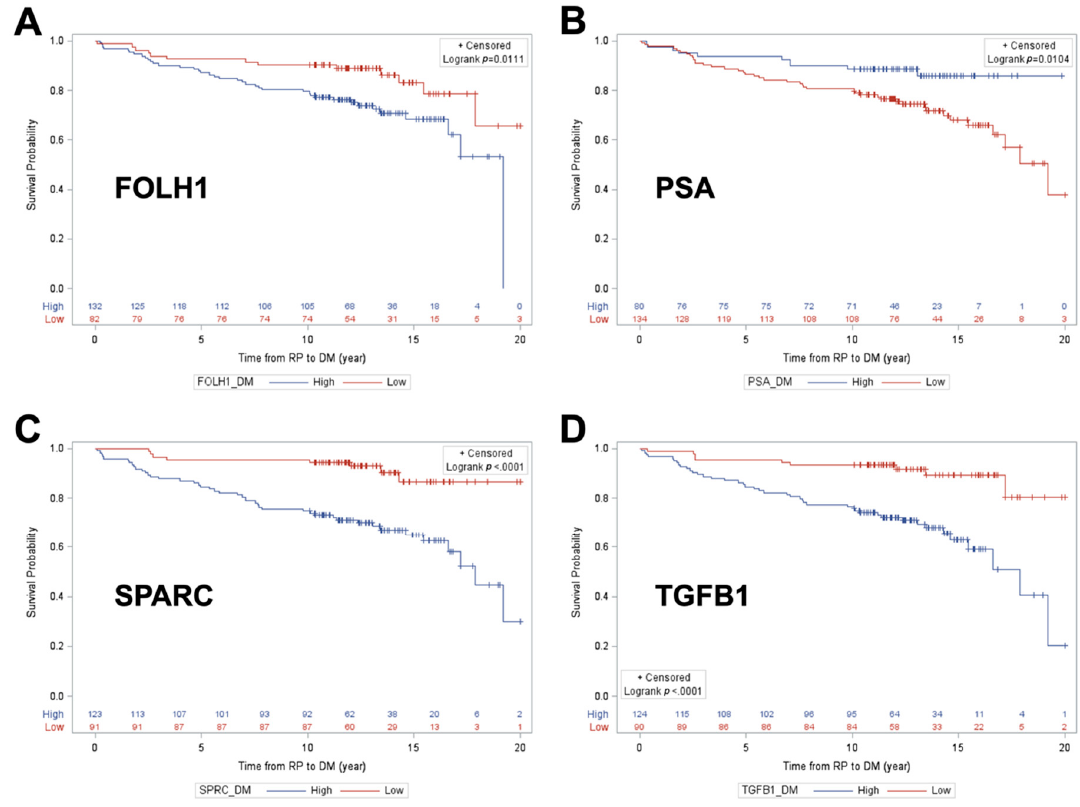
Figure 2. Kaplan–Meier DM-free survival curves across high versus low groups for FOLH1 ( A ), PSA ( B ), SPARC ( C ), and TGFB1 ( D ).